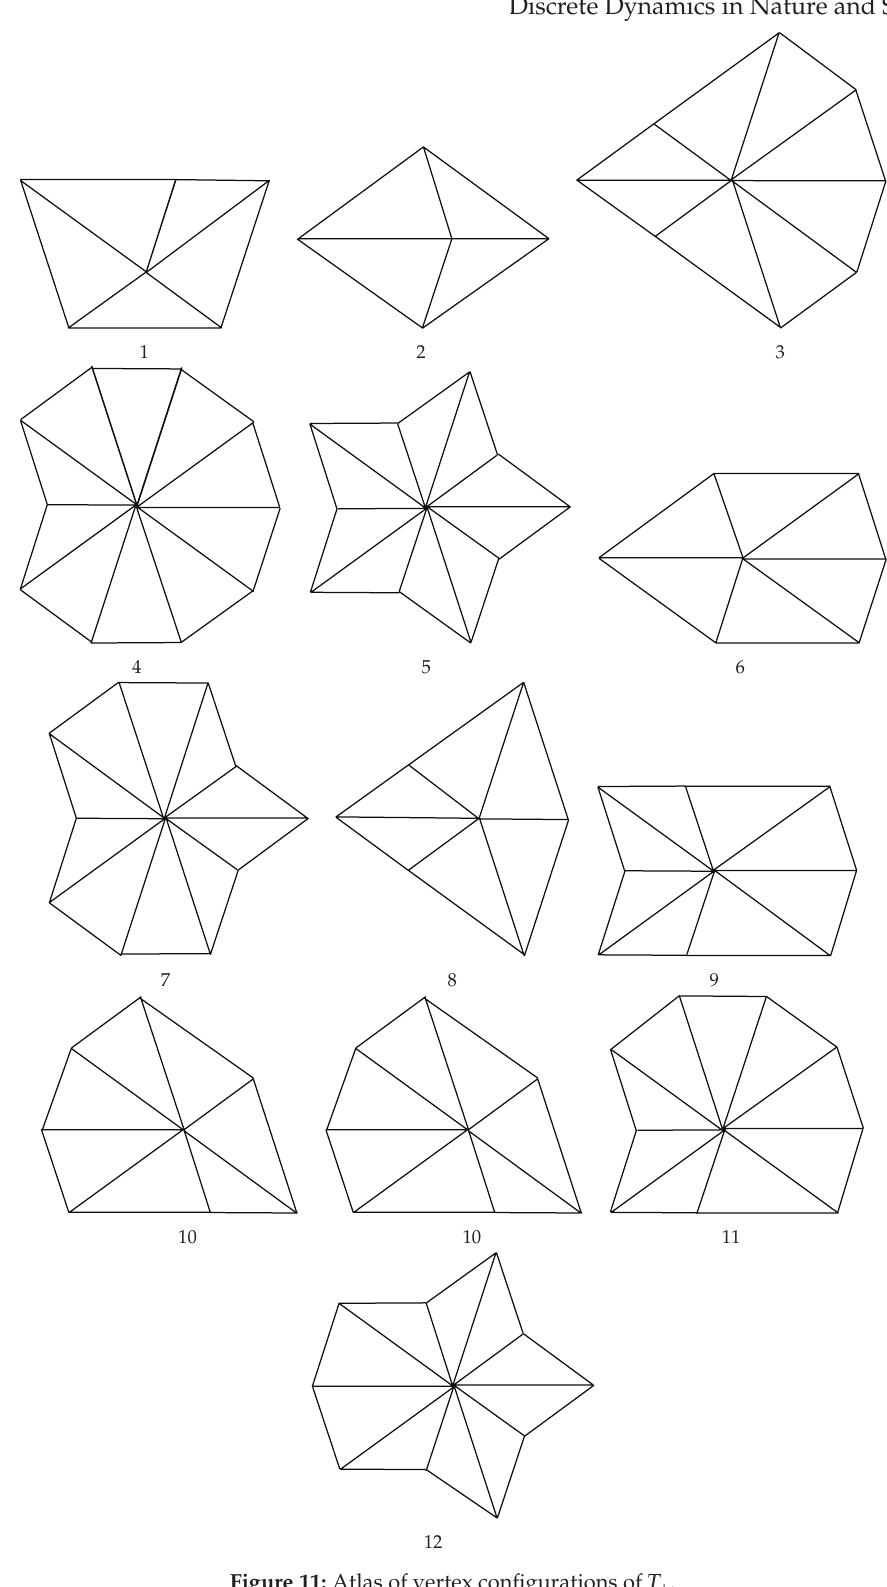
Figure 11: Atlas of vertex configurations of T (cid:8)